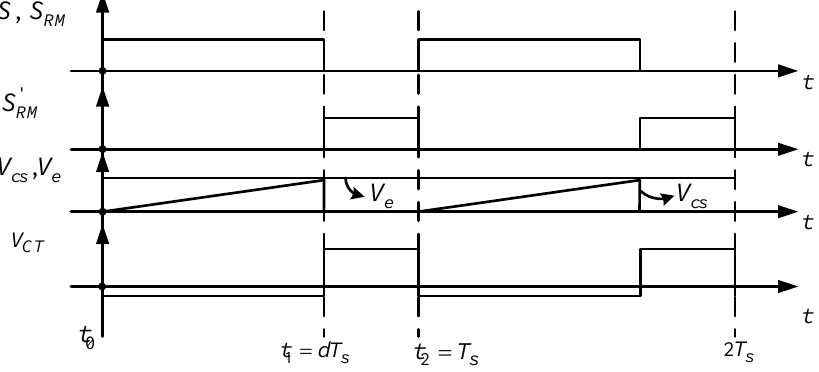
Figure 9. Control signals of the adopted boundary-mode control strategy.